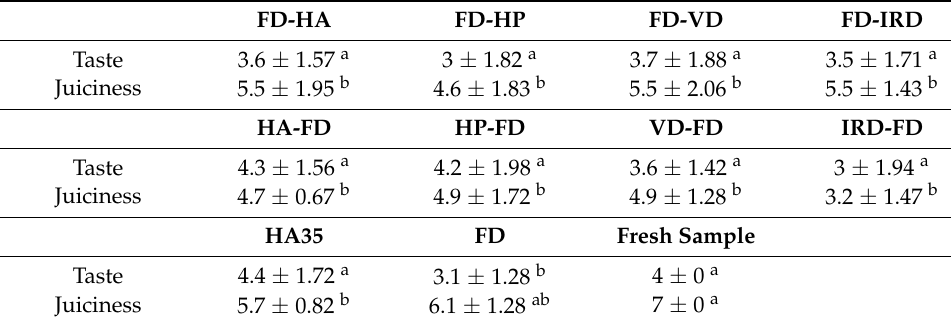
Table A3. Sensory evaluation of freeze drying (FD) combined drying at 35 ◦ C.